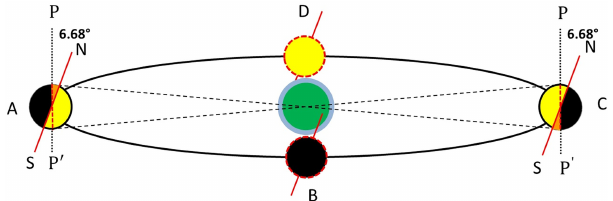
Figure 3. Libration in latitude results from an inclination of 6.68 ◦ between the Moon’s axis of rotation (NS) and the normal to the plane of its orbit around Earth (PP (cid:48) ). The hemisphere of the Moon that is visible from Earth at point D is marked in yellow; black is the invisible hemisphere at point B. Additional areas of the lunar surface that become available for observation at points A and C are marked in orange. View from the point close to the ecliptic